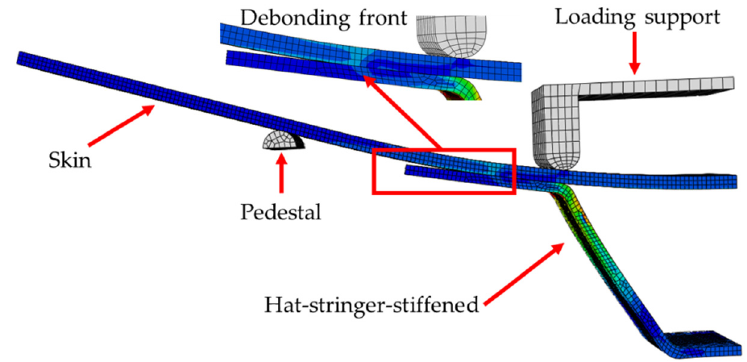
Figure 10. Numerical results of the static four-point bending tests. Table 4. The initial debonding load and displacement of the tested specimens.